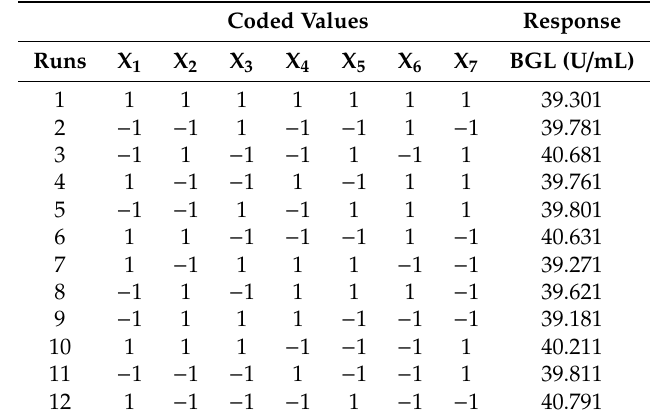
Table 2. Plackett-Burman Design. Multiple screening designs for identification of most influential factors on the production of S.griseus recombinant β -glucosidase. It depicts coded values of the designs, along with the observed experimental response ( β -glucosidase activity (BGL); U /